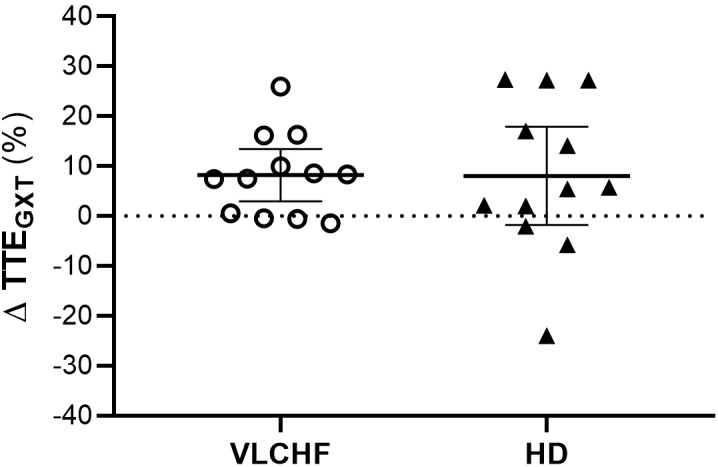
Individual responses of total time to exhaustion in GXT (TTEGXT).